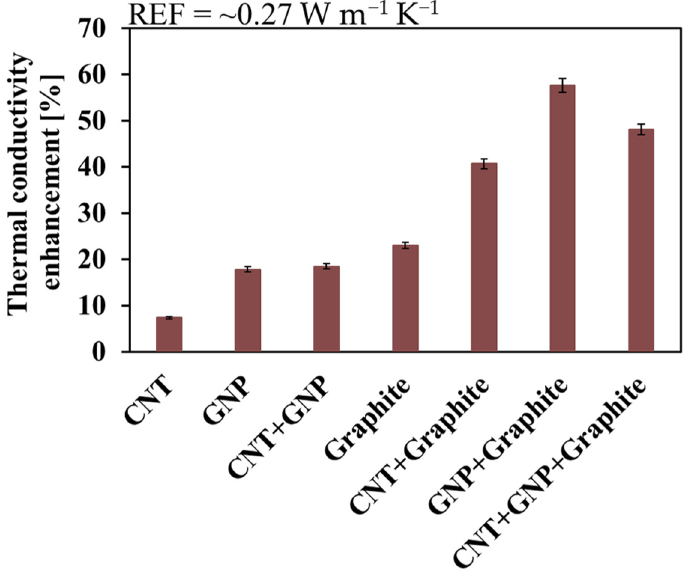
Figure 3. Thermal conductivity enhancement of the various systems. The measured values and their errors are detailed in Table S1.